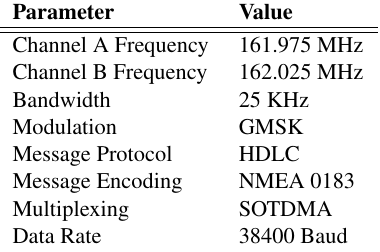
Figure 1. AIS reported vessel density around South